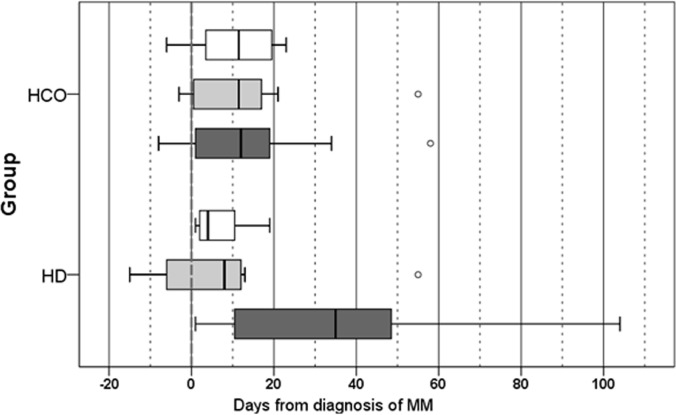
Time intervals from day of clinical MM diagnosis (= 0) to start of chemotherapy, kidney biopsy and renal replacement therapy (median, 25th percentile, 75th percentile, minimum, maximum).